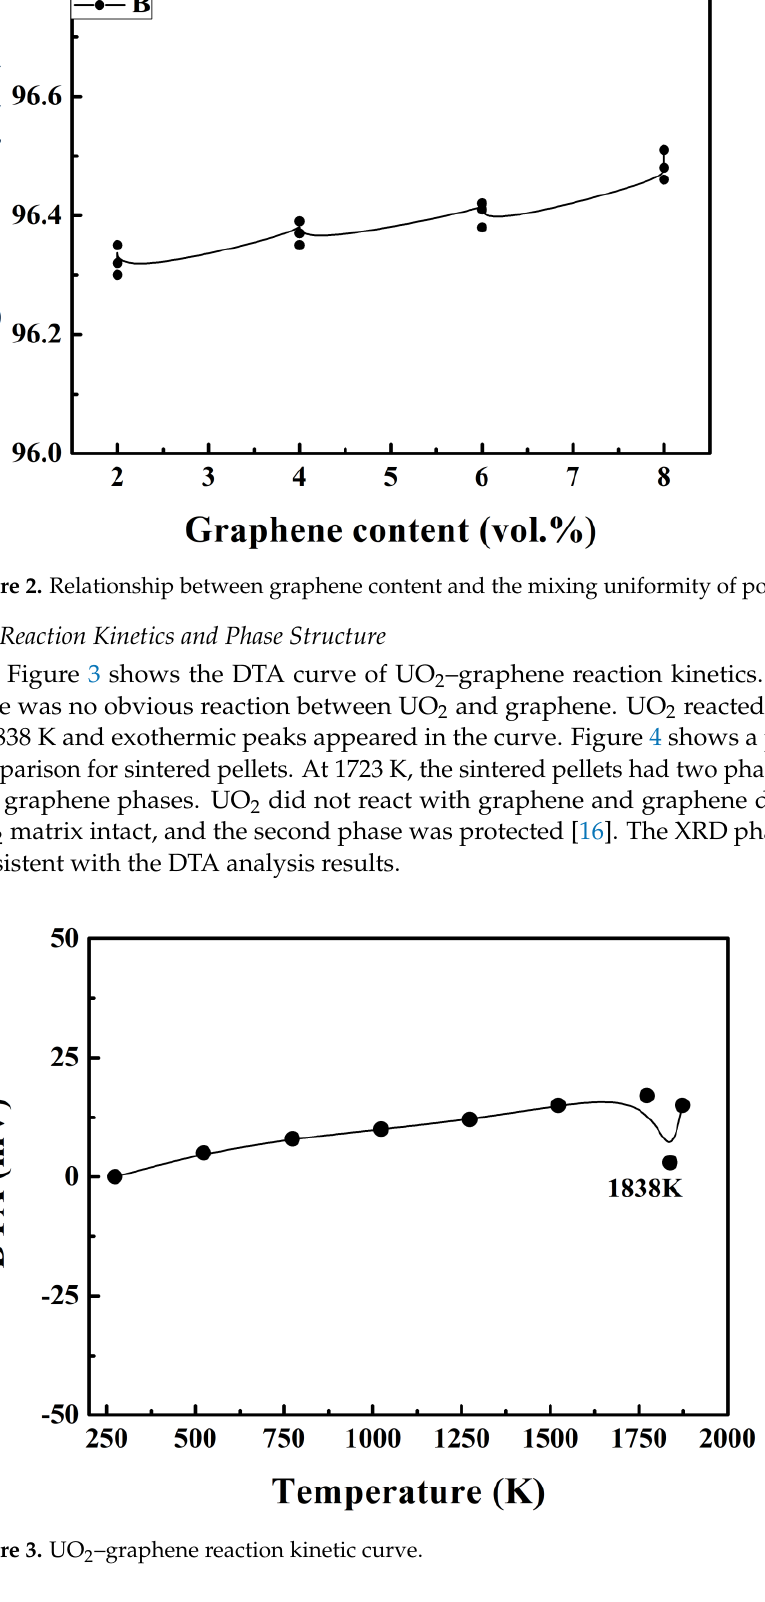
Figure 3. UO 2 –graphene reaction kinetic curve.